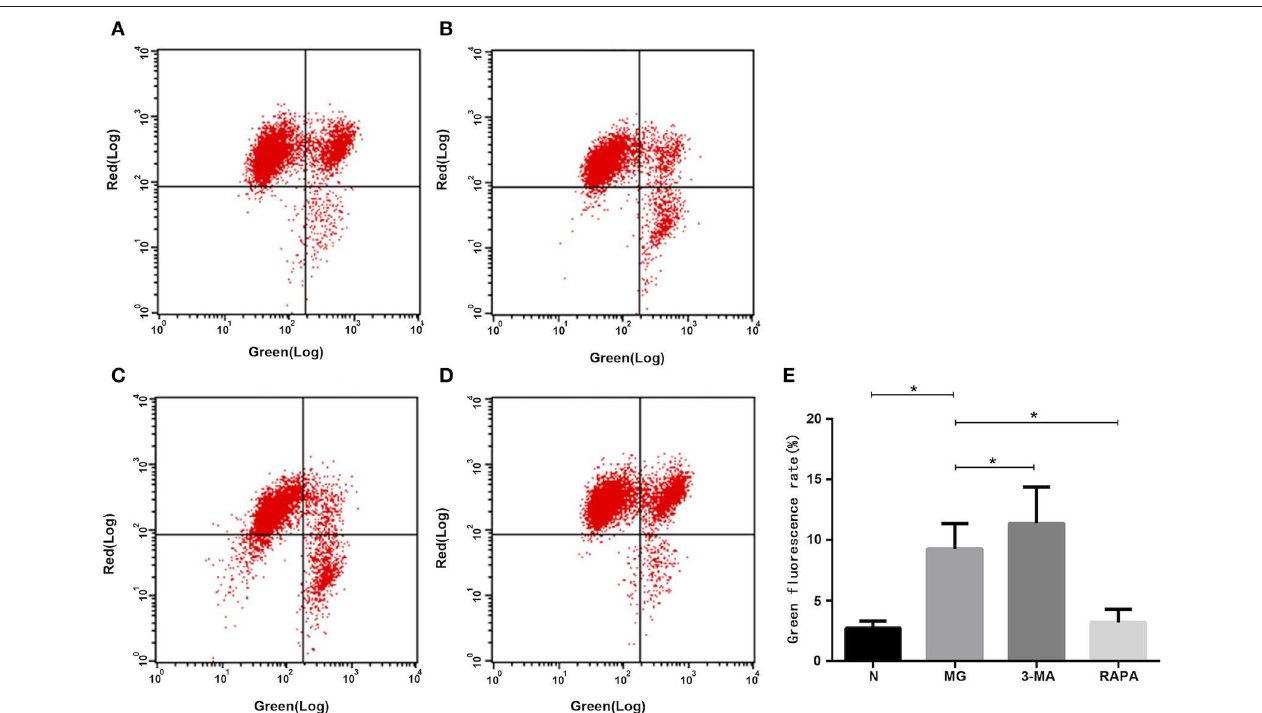
FIGURE 4 | Mitochondrial membrane potential. In the flow cytometry images, G indicates green fluorescence, R indicates red fluorescence. Mitochondrial membrane potential in the (A) healthy control group, (B) MG group, (C) , 3-MA pretreatment group, (D) Rapa pretreatment group, and (E) Statistical analysis results are shown as (* P <